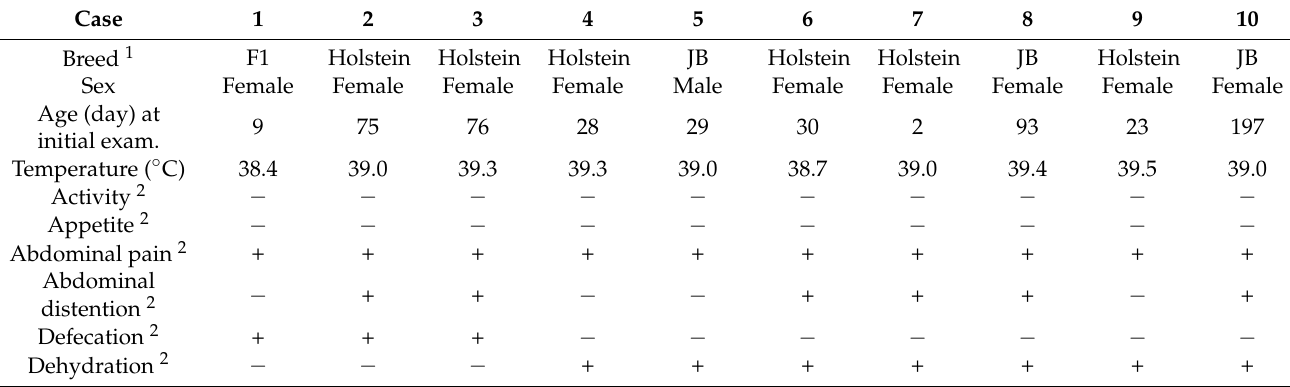
Table 1. Clinical data in ten present